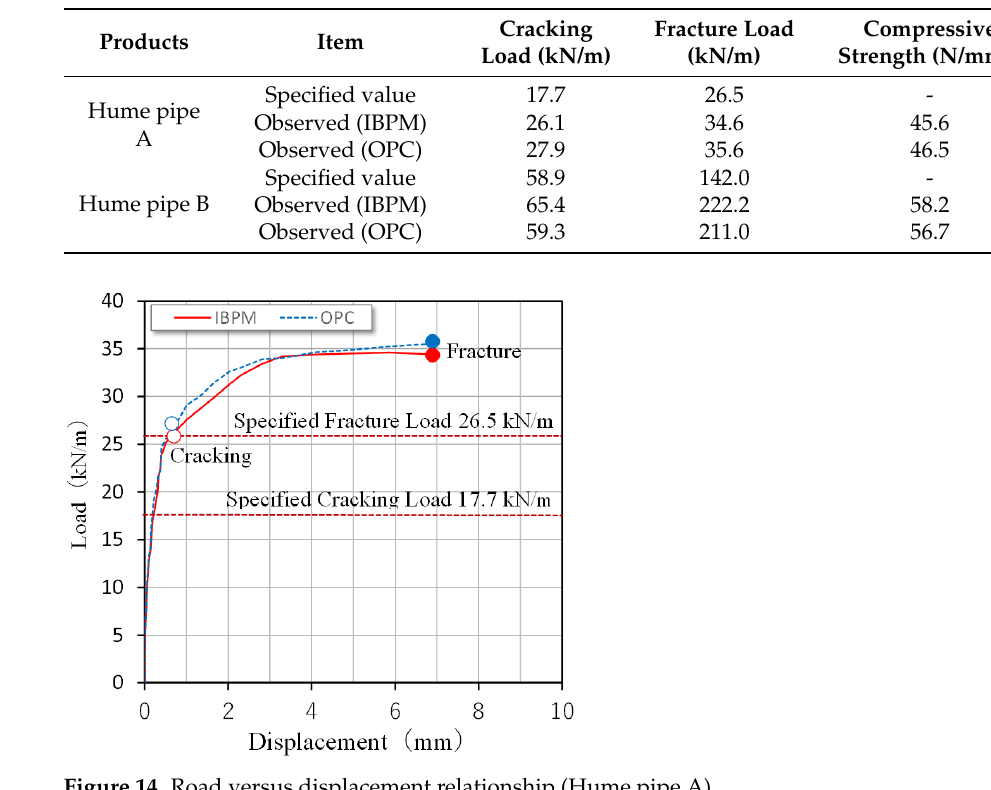
Figure 14. Road versus displacement relationship (Hume pipe A).